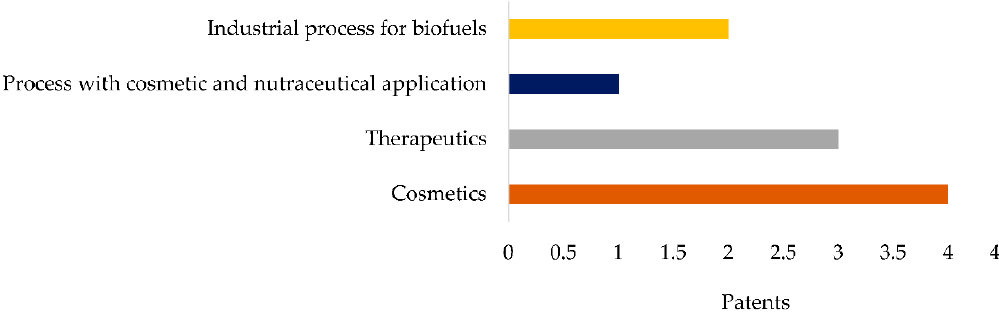
Figure 4. Distribution of patent deposits by application area. Table 8. Records of patent applications and/or patents granted with products developed from bacuri ( Platonia insignis Mart.).